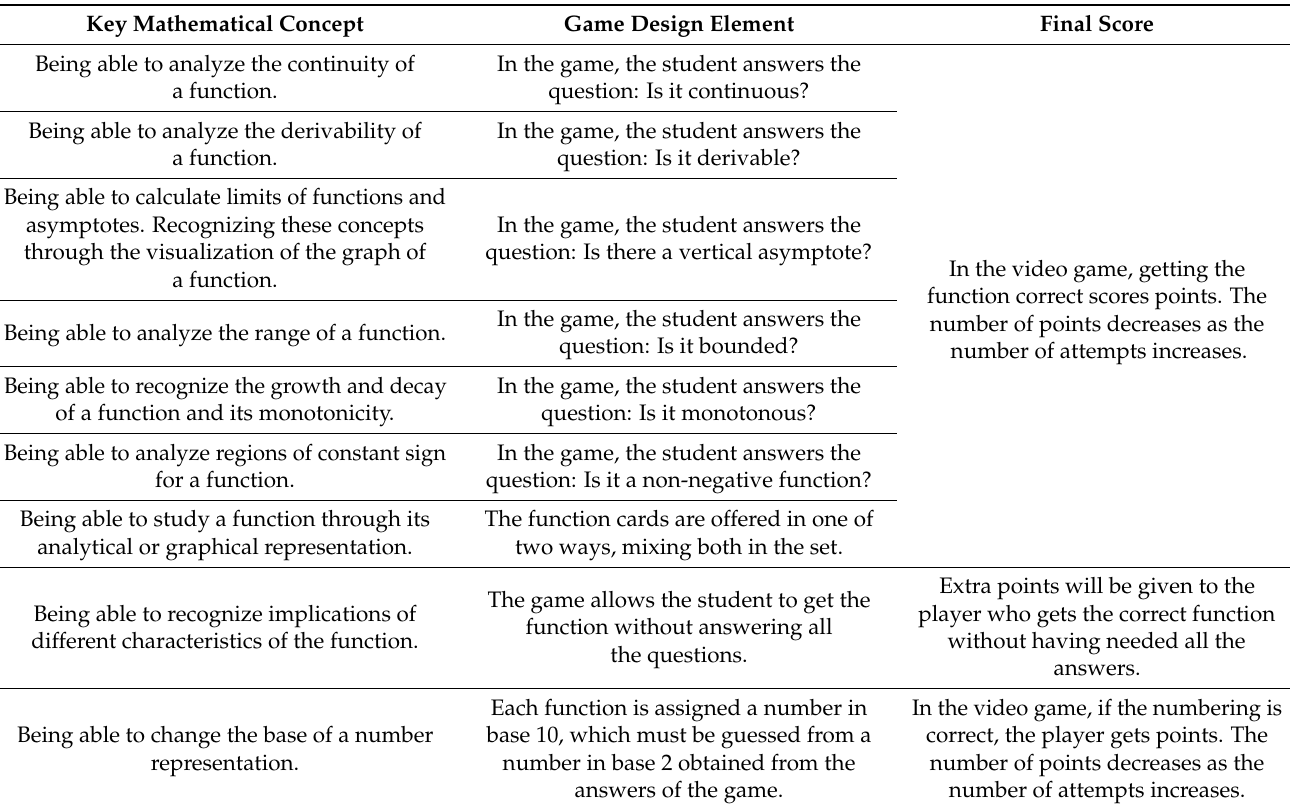
Table 3. Concepts tackled in the